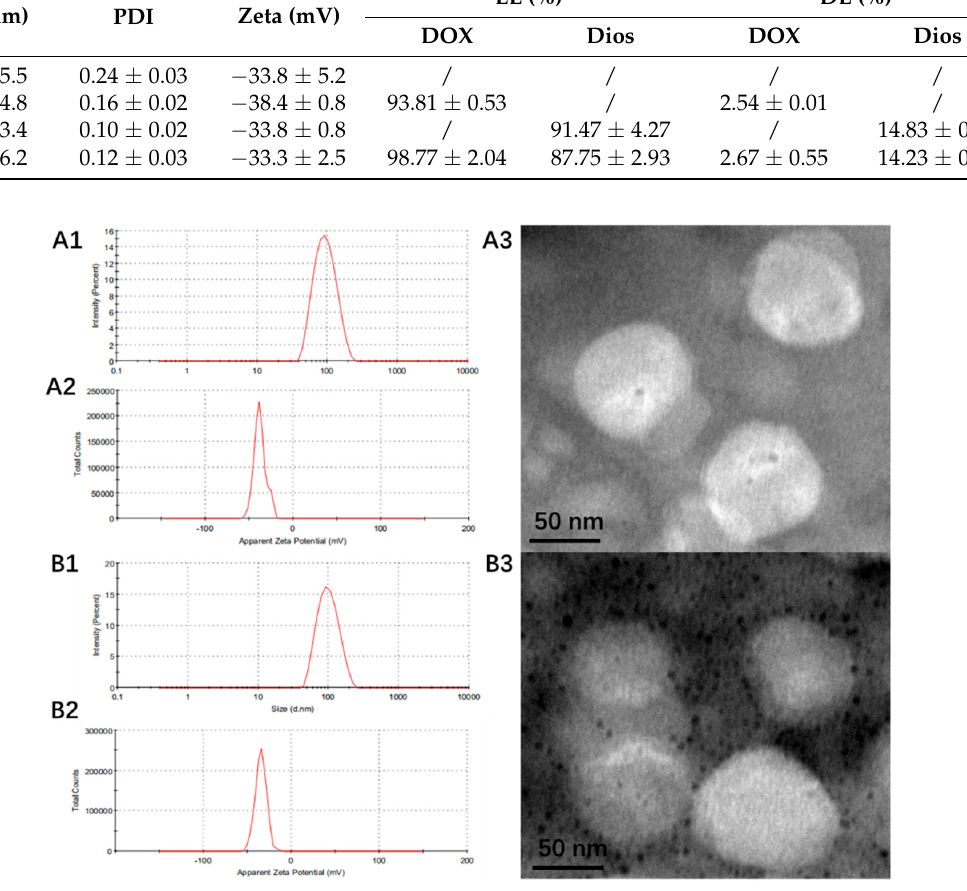
Figure 2. The particle size ( A1 ), Zeta ( A2 ) and the morphology ( A3 ) of CHOL-DOX-LP; The particle size ( B1 ), Zeta ( B2 ) and the morphology ( B3 ) of Dios-DOX-LP.